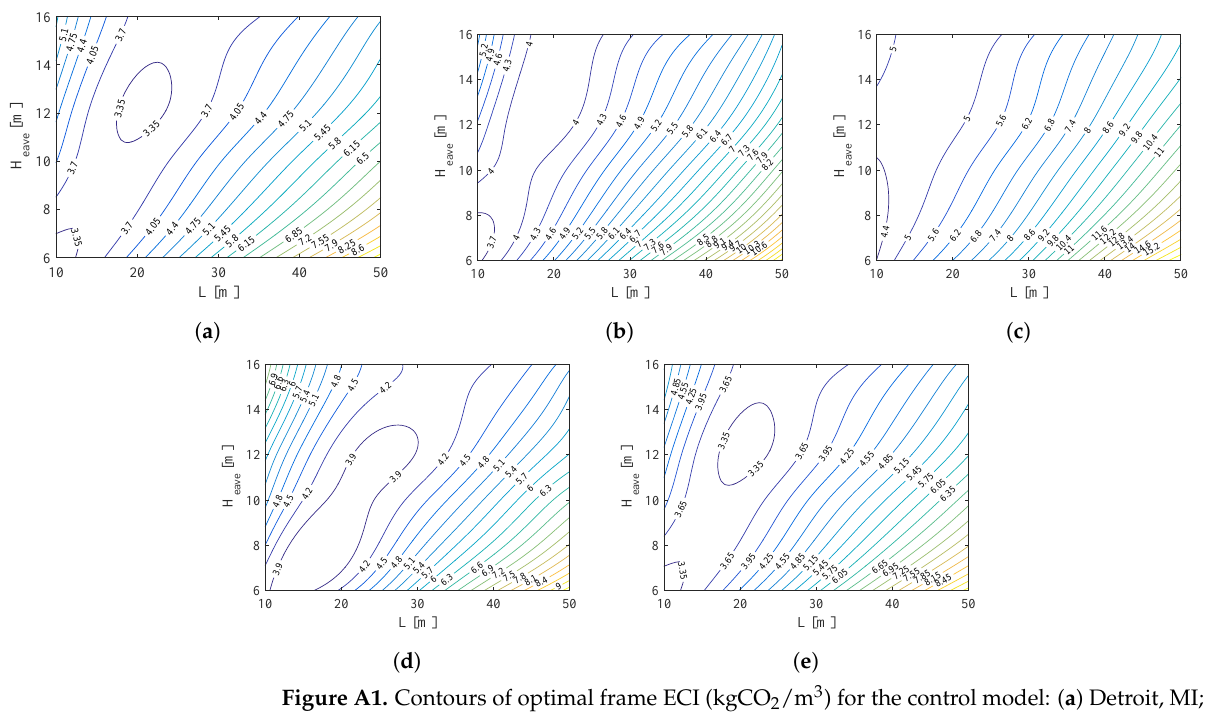
Figure A1. Contours of optimal frame ECI (kgCO 2 /m 3 ) for the control model: ( a ) Detroit, MI; ( b ) St. Paul, MN; ( c ) Berlin, NH; ( d ) Miami, FL; ( e ) St. Charles, KY.